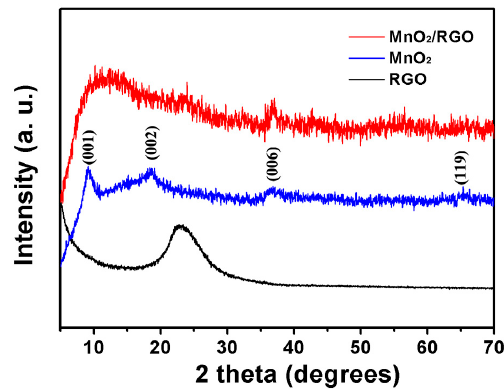
Figure 2. XRD patterns of MnO 2 , RGO, and MnO 2 /RGO.